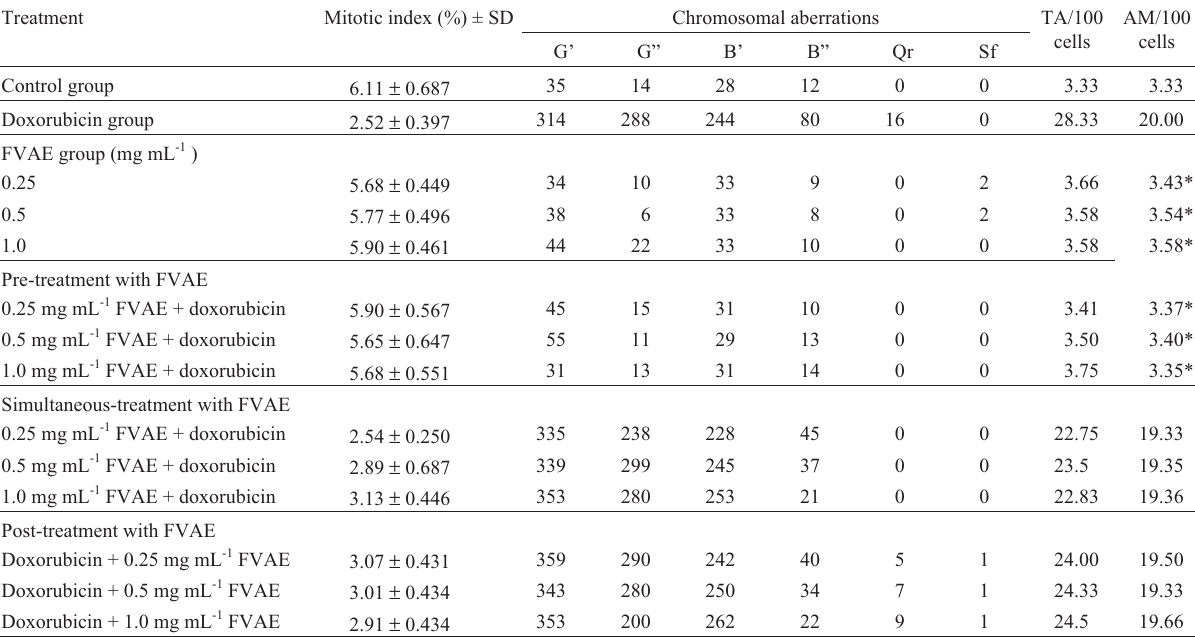
Table 1 - Mitotic index and chromosomal aberrations in human lymphocytes from 12 women treated with Fucus vesiculosus aqueous extract (FVAE) and/or 15 μ g mL -1 of